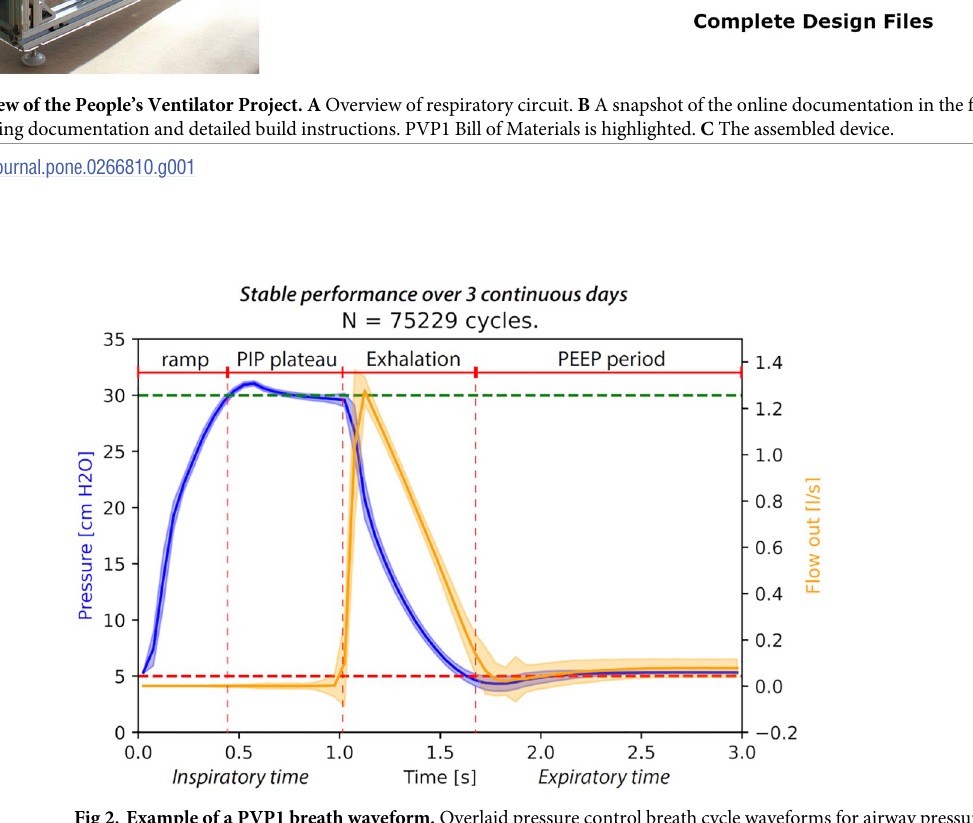
PLOS ONE | https://doi.org/10.1371/journal.pone.0266810 May 11, 2022 3 /